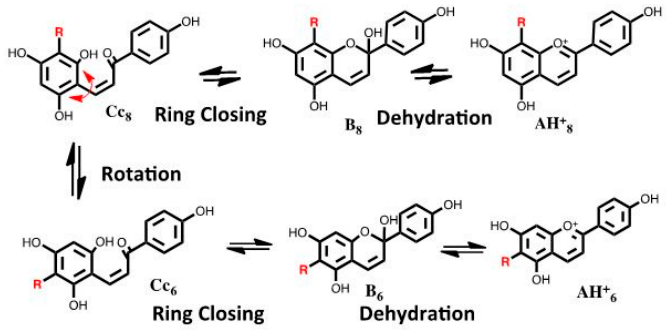
Scheme 14. Key step of the 6,8 rearrangement in flavylium multistates.